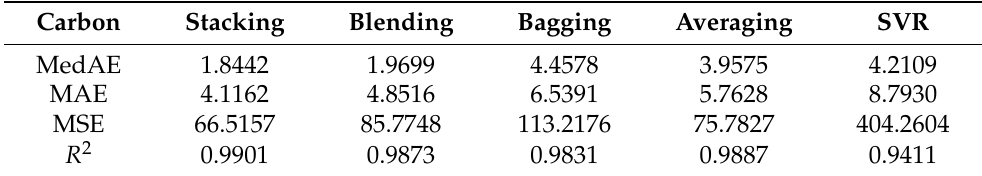
Table 5. Carbon monoxide prediction results.